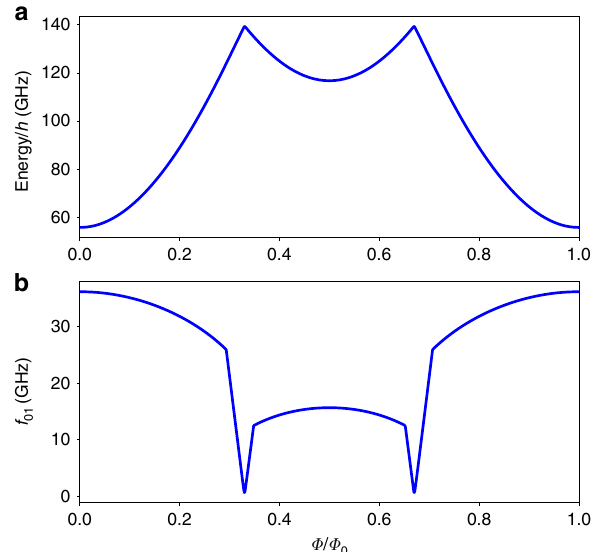
Fig. 2 Magnetic fi eld dependence of the transition frequencies of the twin qubit. The energy of the ground state ( a ) and the transition energy hf 01 of the twin qubit calculated from the Hamiltonian of Eq. (1) ( b ). The parameters α = 0.72 and C = 5.2 fF and the Josephson energy is E J = 50 GHz. These dependencies are Φ 0 periodic and symmetric with respect to Φ / Φ = 0.5. The minimum point of the ( b ) plot corresponds to the 0 transition of the central junction phase φ 0 from zero to